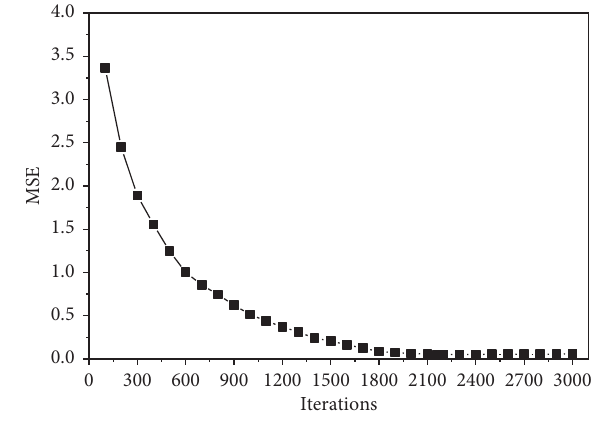
Figure 8: MSE for each iteration.